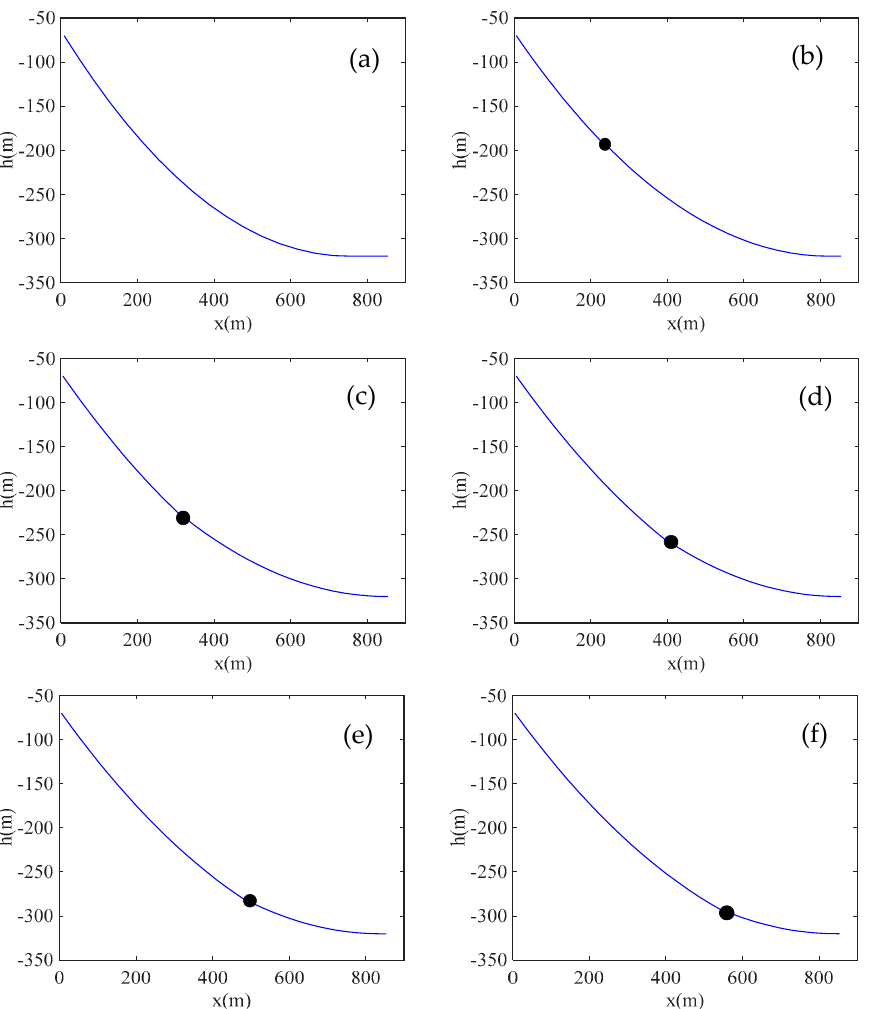
Figure 3. Shape of mooring line with clump masses mounted at different locations: ( a ) P0, ( b ) P1, ( c ) P2, ( d ) P3, ( e ) P4, ( f ) P5.